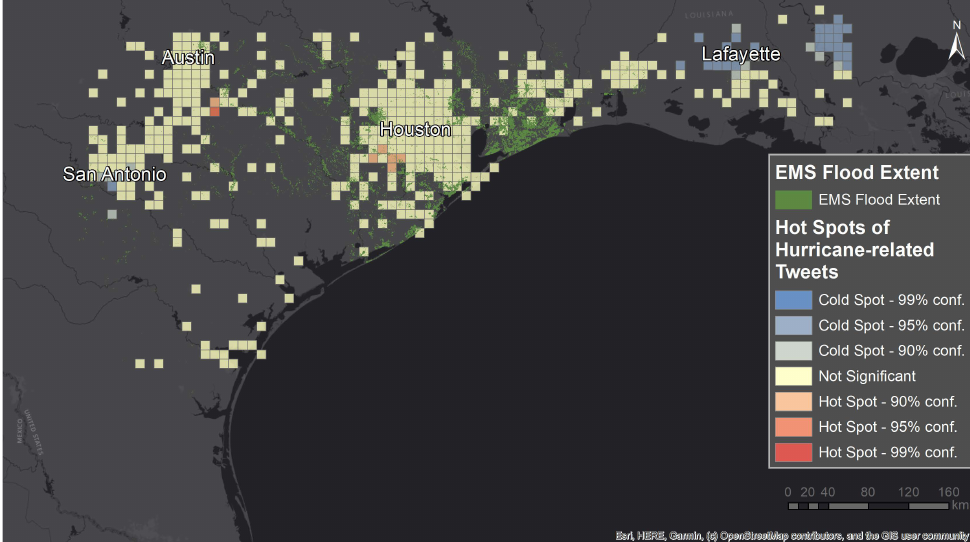
Figure 8. Hurricane hot and cold spots obtained using plain LDA compared to COPERNICUS Emergency Management Service (EMS) [45] mapping data depicting flooded areas six days after the